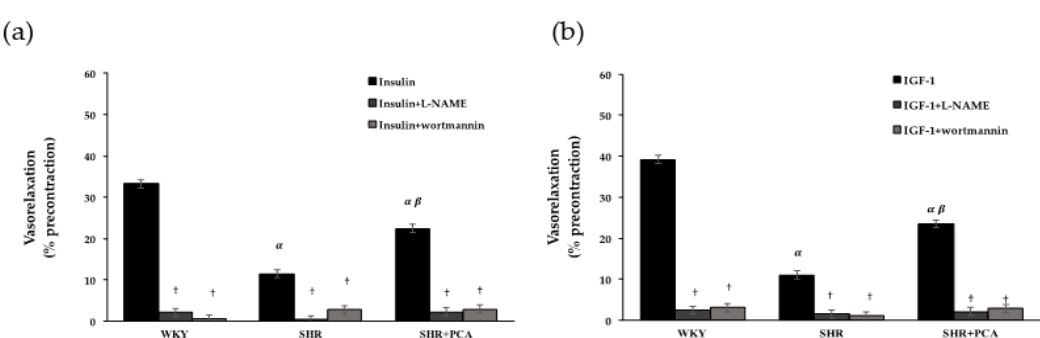
Figure 3. ( a ) Insulin (10 − 6 M)-induced vasorelaxation and ( b ) IGF-1 (3 × 10 − 8 M)-induced vasorelaxation after the 15-min pre-incubation with wortmannin (3 × 10 − 7 M) or nitro- L -arginine methyl ester ( L -NAME) (10 − 6 M) among the WKY, SHR, and SHR+PCA groups. α , p < 0.05, significant differences from WKY; β , p < 0.05, significant differences from SHR; †, p < 0.05, significant differences from no inhibitors; n = 8 in each group.